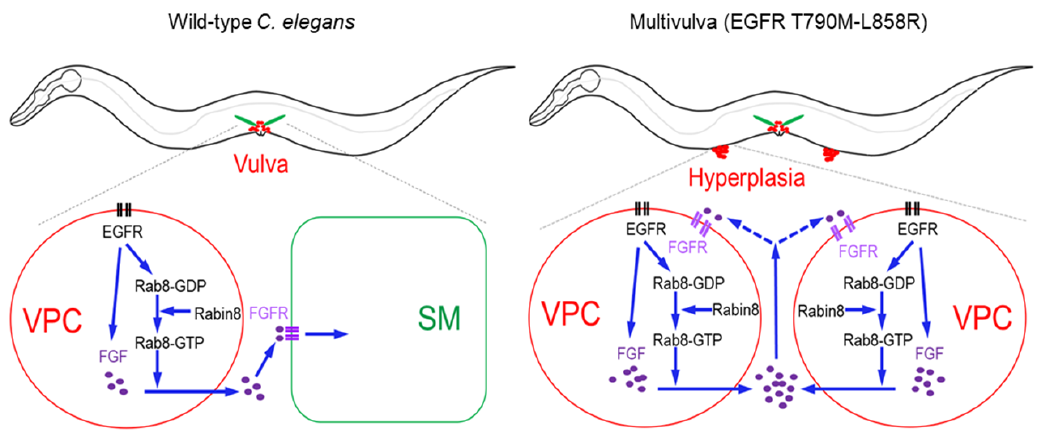
Figure 8. Proposed model of Rab8 and Rabin8 for Muv formation in C. elegans expressing a hyperactive human EGFR mutant. In the wild-type worm, EGFR signaling in VPCs induces FGF expression and its secretion via Rab8 and Rabin8. Secreted FGF acts on sex myoblast (SM) cells expressing FGFR, and thus induces migration and di ff erentiation of SM to form vulval muscles (left panel). In the multivulva worms expressing a hyperactive EGFR mutant, excessive EGFR signaling in VPCs results in increased FGF production and secretion, leading to Muv formation in addition to the normal vulva. Autocrine or paracrine of FGF signaling may act among daughter cells of extra vulval precursor cells (right panel).